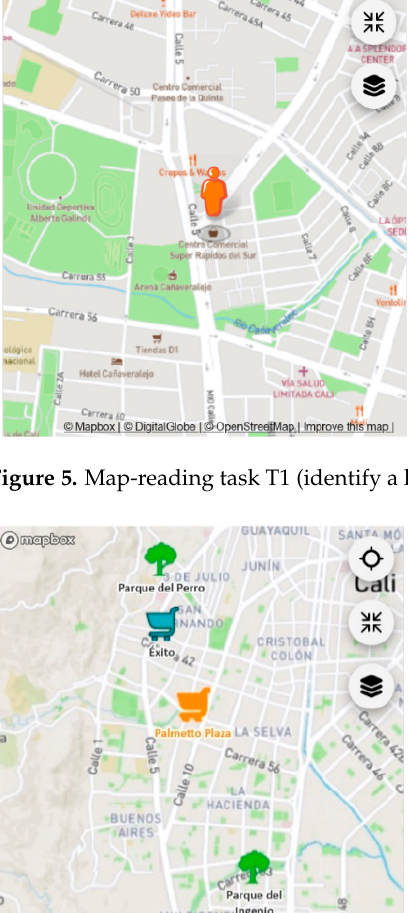
Figure 5. Map-reading task T1 (identify a location on the map) with the Mapbox Streets base map.